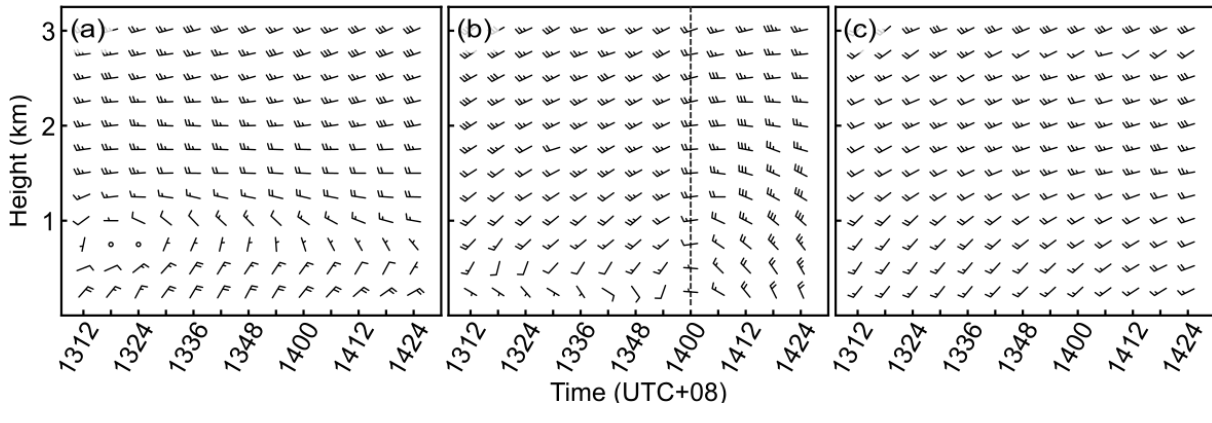
Figure 7. Time series of VWPs computed from the HA ( a ), JH ( b ), and NJ ( c ) radars from 1312 to 1424 LTC. The half and full wind barbs represent 2.5 m s −1 and 5 m s −1 , respectively. The dashed line in ( b ) marks the time of the veering lower- level